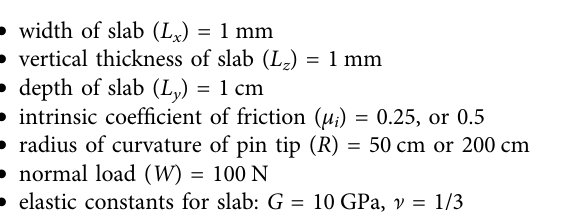
FIGURE 9 | Force in coupling spring as a function of time while pin is being driven by a stage that translates at a constant velocity of 2 mm/s, for two different intrinsic static coef fi cients of friction. In each case pin experiences a position-dependent friction force de fi ned by the nanometer-scale friction function per Figure 6